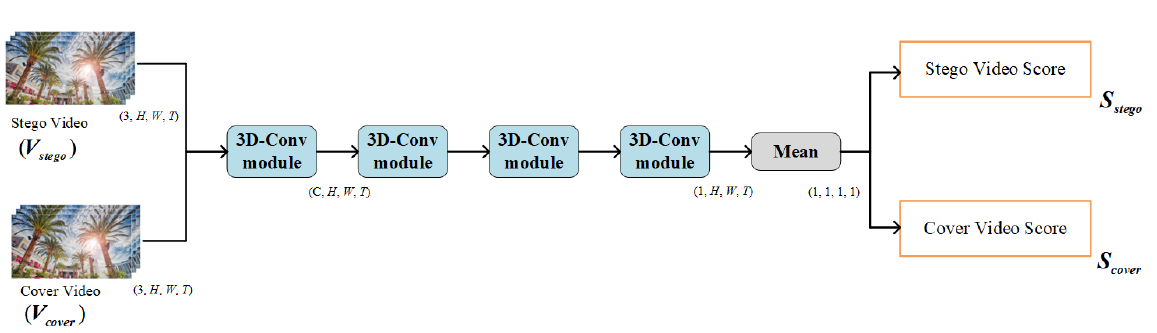
Figure 4. The network design of discriminator.